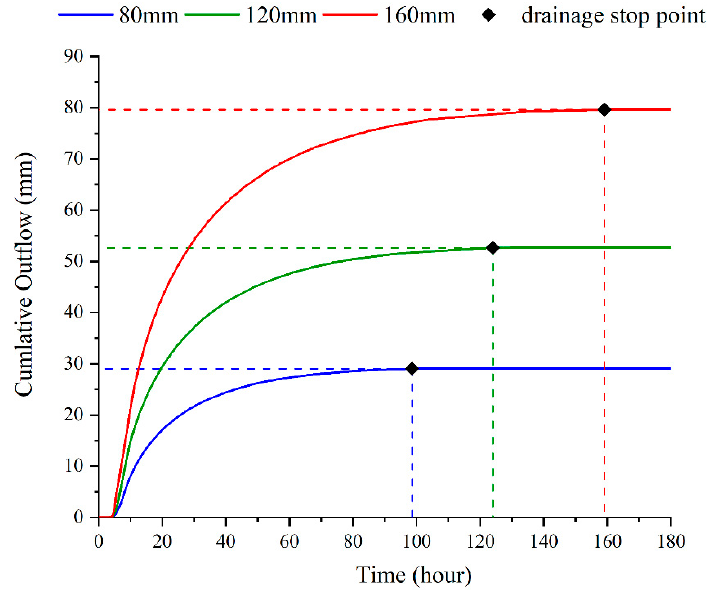
Figure 7. Cumulative amount of outflow under three leaching amounts.